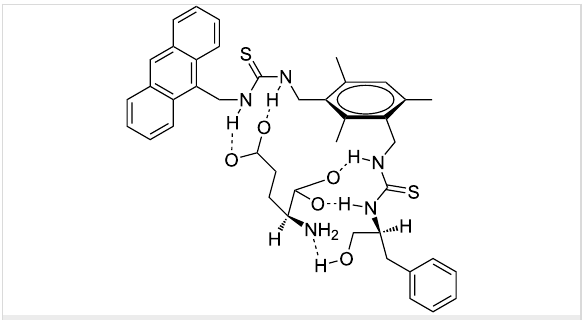
Figure 2: Proposed three sites binding model for sensor 2 and gluta- mate